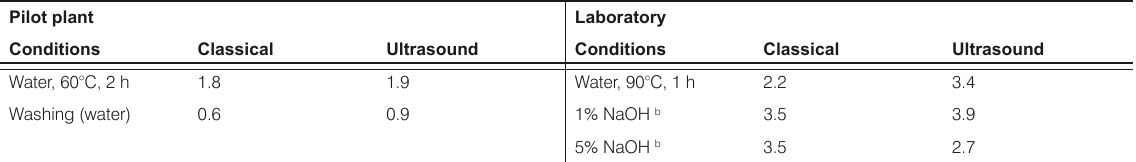
a In % related to dry EIR; b At room temperature for 2 h. Table 3. Effect of ultrasonication on the yield of polysaccharides extracted from the ethanol-insoluble residue (EIR) of valerian by hot water (P1) and by dialysis of the ethanolic extract (TP).